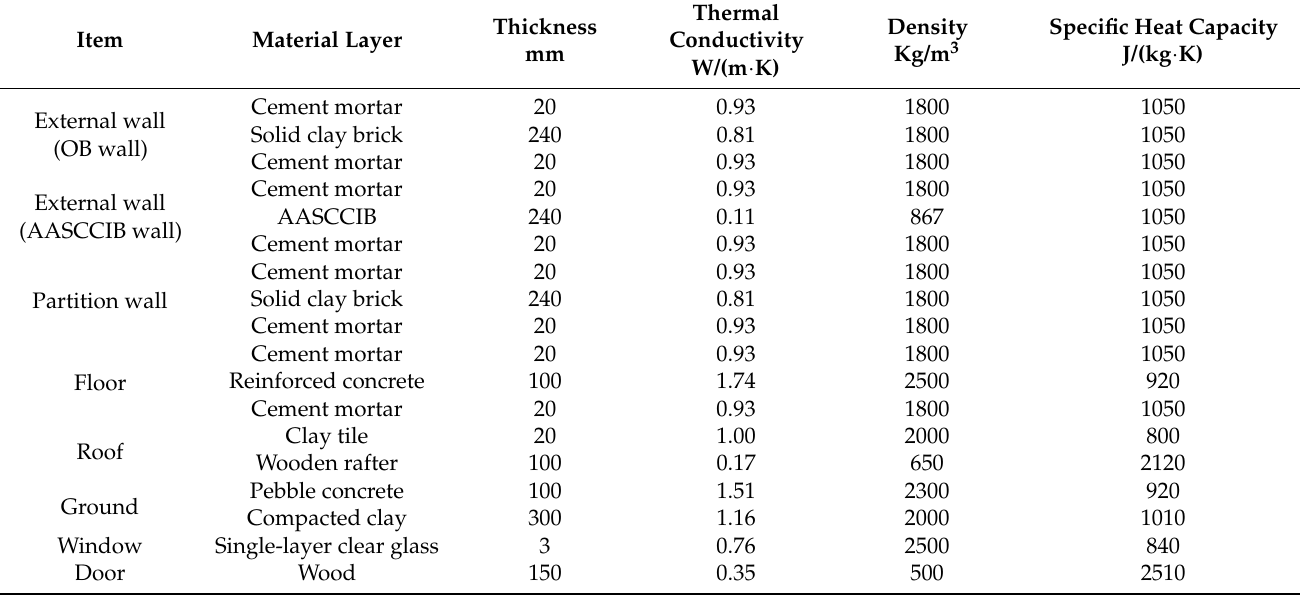
Table 4. Thermal parameters of the